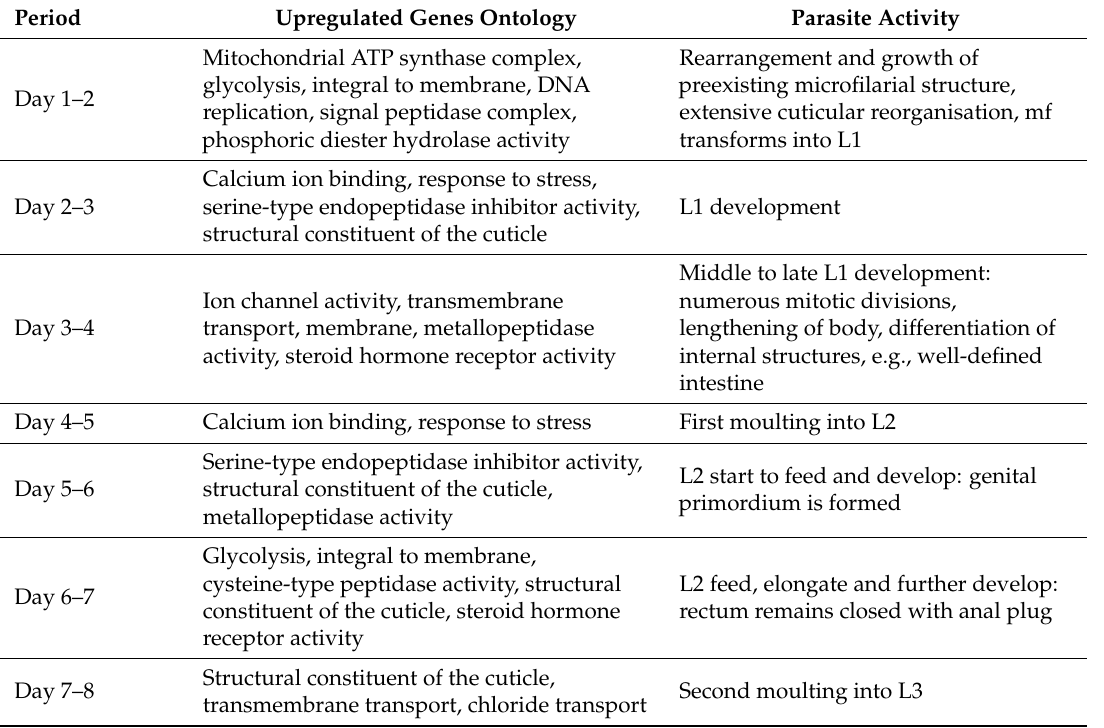
Table 1. Chronological RNA-seq expression profiles of Brugia malayi in Aedes